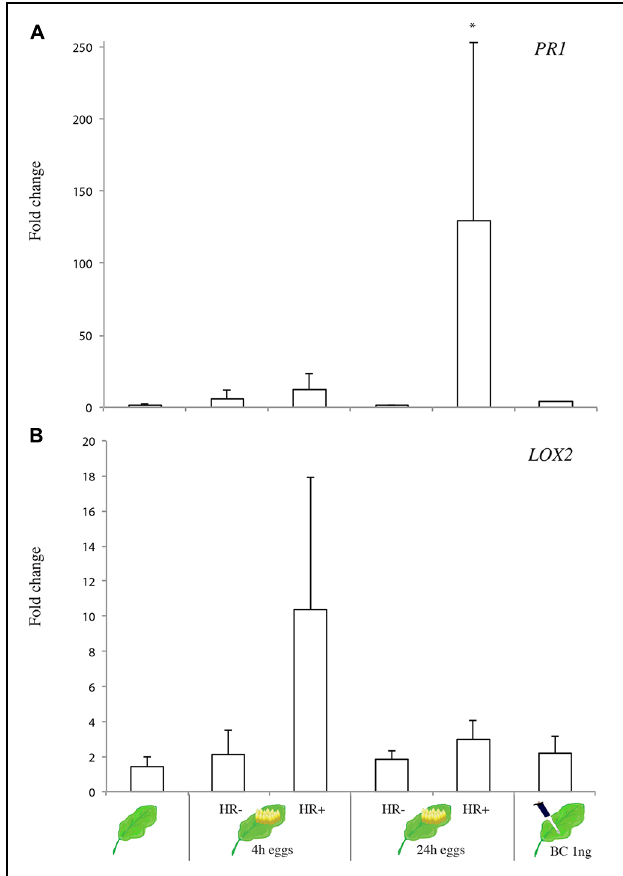
FIGURE 5 | Gene expression of (A) PR1 and (B) LOX2 genes in B. nigra plants exhibiting a HR-like necrosis (HR + ) or not (HR − ) infested by P. brassicae eggs (4 and 24 h after oviposition) or in plants treated with BC (1 ng). Bars represent mean expression levels normalized (relative to the reference gene GAPDH ) as 2 − (cid:2)(cid:2) Ct with standard error bars ( n =